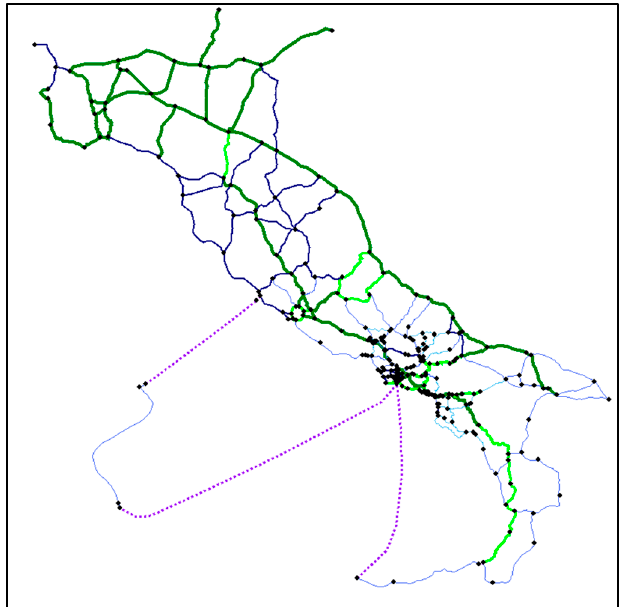
Figure 7. Road network (national model).